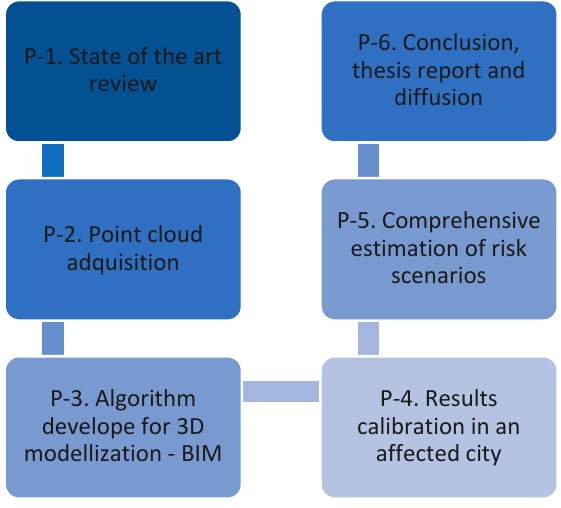
Figure 1. Thesis methodology